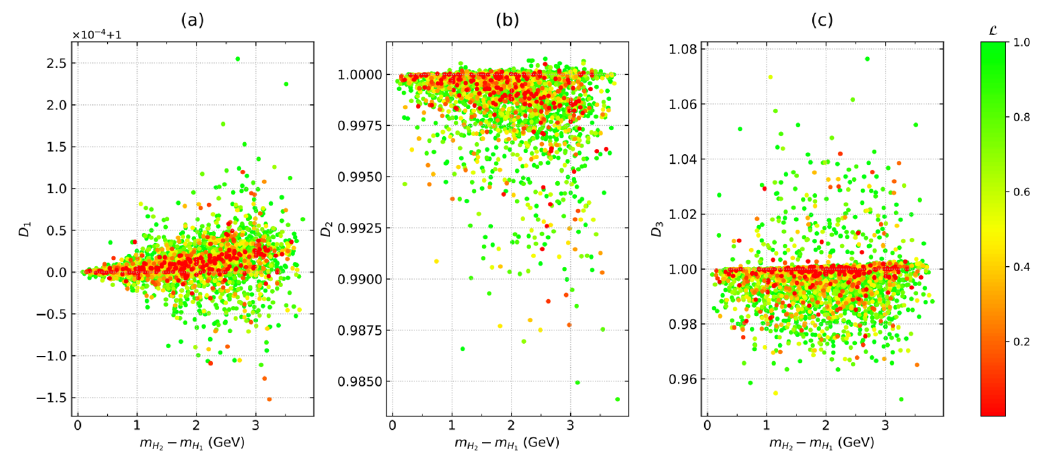
versus D ( i = 1 , 2 , 3) . − m H i 2 1 , while samples with red color are in poorer µ